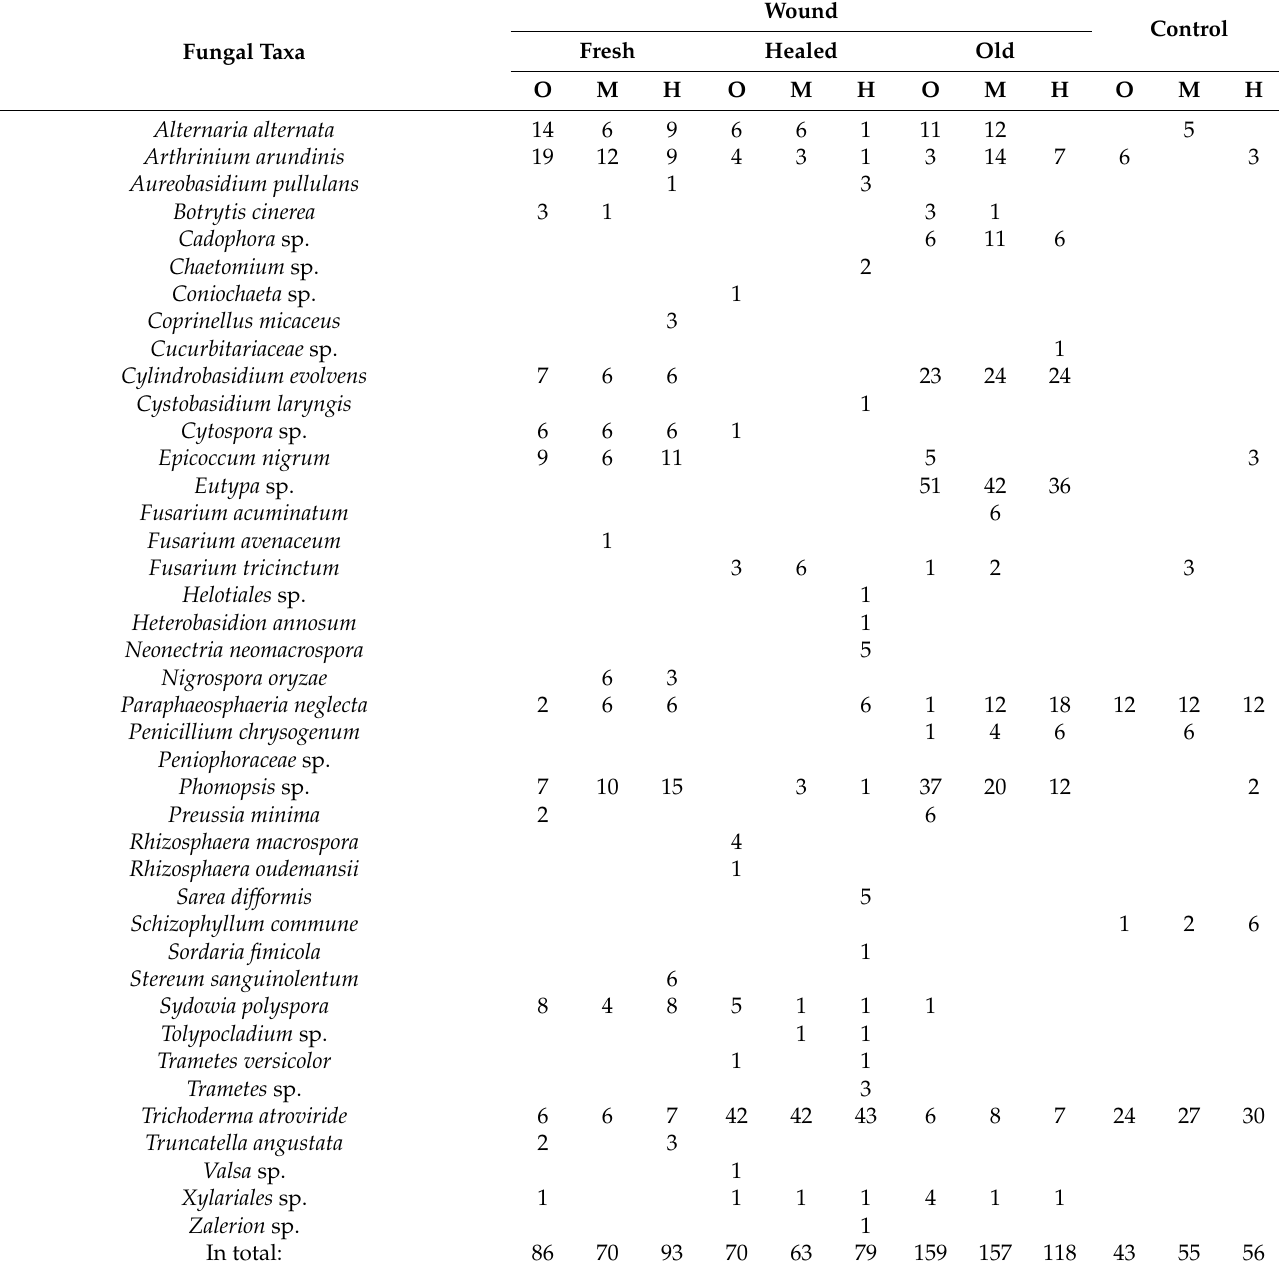
Table 3. Fungi colonies isolated from sapwood of bark-stripped Abies alba firs depending on wound type and habitation depth (O—outside part of wood; M—middle part of wood; H—the part near heartwood).